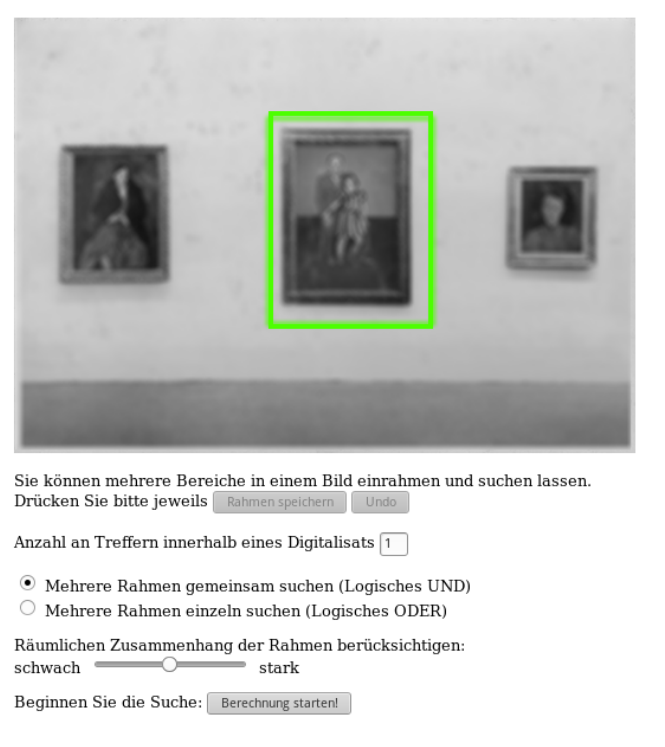
Figure 8. User’s selection of Balthus’ portrait of Miró and his daughter Dolores on the Interface.